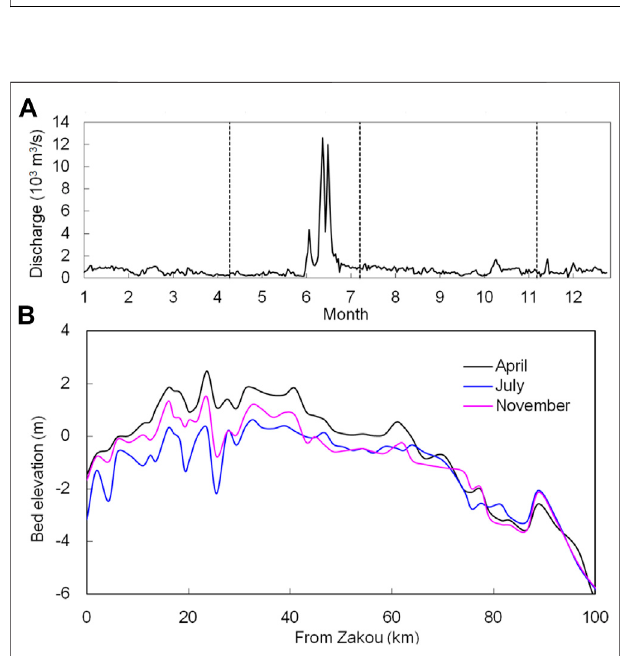
FIGURE3| Timeseriesofdailyriverdischargein2015 (A) andthecross- sectional bed level along the estuary in april, July and November of 2015 (B) . The dashed lines in panel (A) denote the bathymetricsurvey periods. Panels a is after Xie et al. (2018).